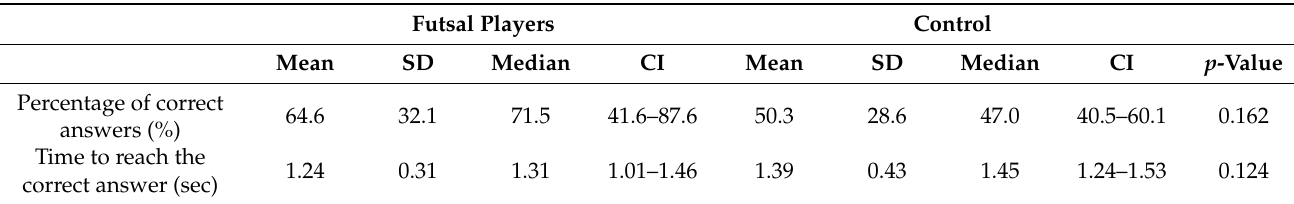
Table 3. Results of coordination and identification test.